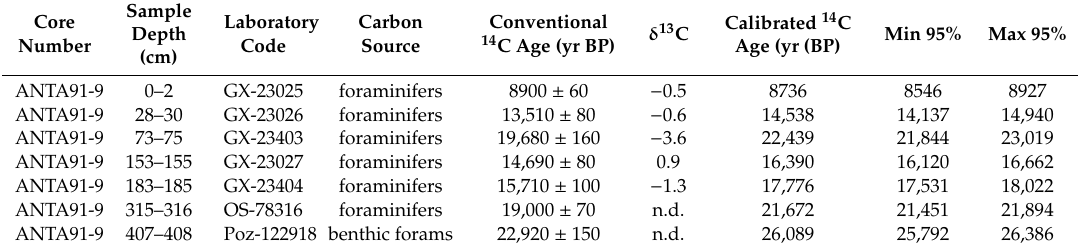
Table 1. AMS 14 C ages with calibrated calendar ages ± 2 σ (yr). The calendar ages are calibrated using the Clam 2.3.2 software [47] with Marine 13 calibration curve [46]. A constant reservoir correction of 1100 ± 200 years with a ∆ R of 700 ± 200 years was applied, as suggested in [45]. Calibrated age ranges at 95% confidence.